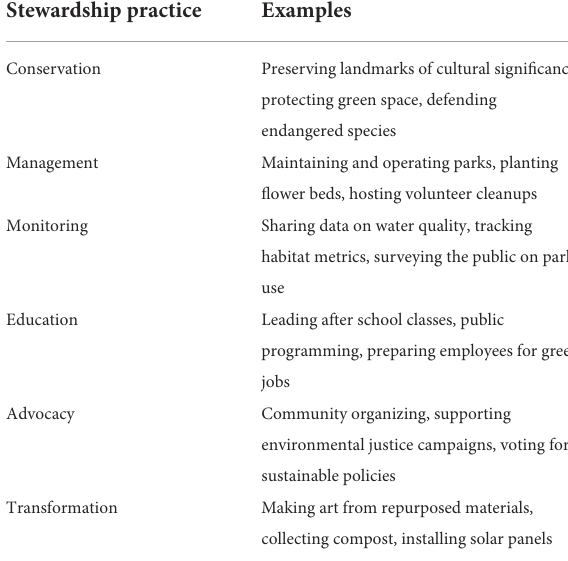
TABLE 1 Stewardship practices adapted from Landau et al.